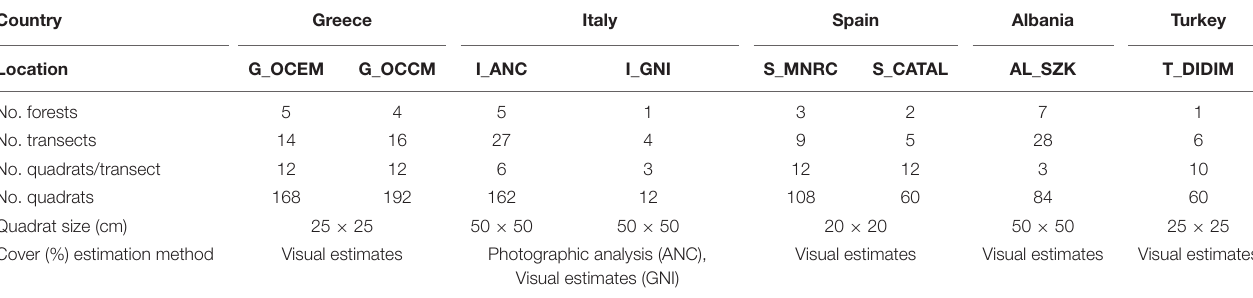
Country Greece Italy Spain Albania